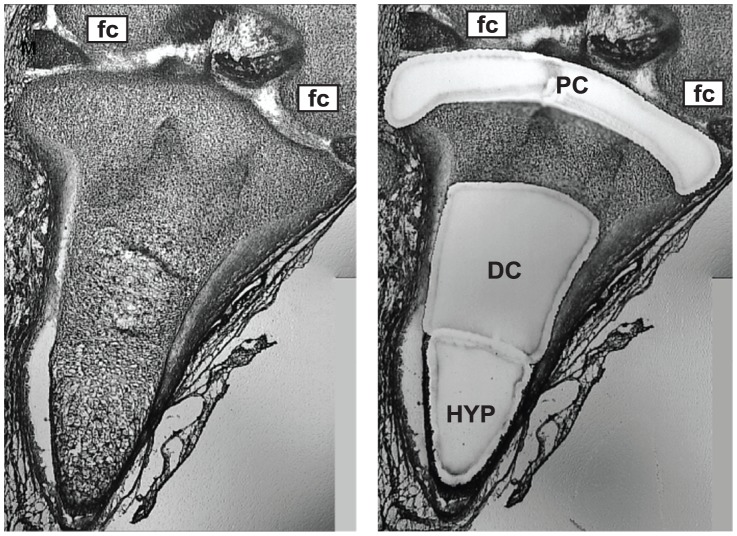
Laser capture microdissection of a human embryonic tibia tissue section (gestational day 54).Left panel shows a processed frozen tissue section and the right panel shows the same tissue section following laser capture microdissection to separate regions containing precursor chondrocytes (PC), differentiated chondrocytes (DC) or hypertrophic chondrocytes (HYP). Also in view is cartilage tissue of the femoral condyles (fc); the developing femur was also micro-dissected to separate the three regions of cartilage. Images were taken using the LMD7000 laser capture microscope set at the 6× objective.